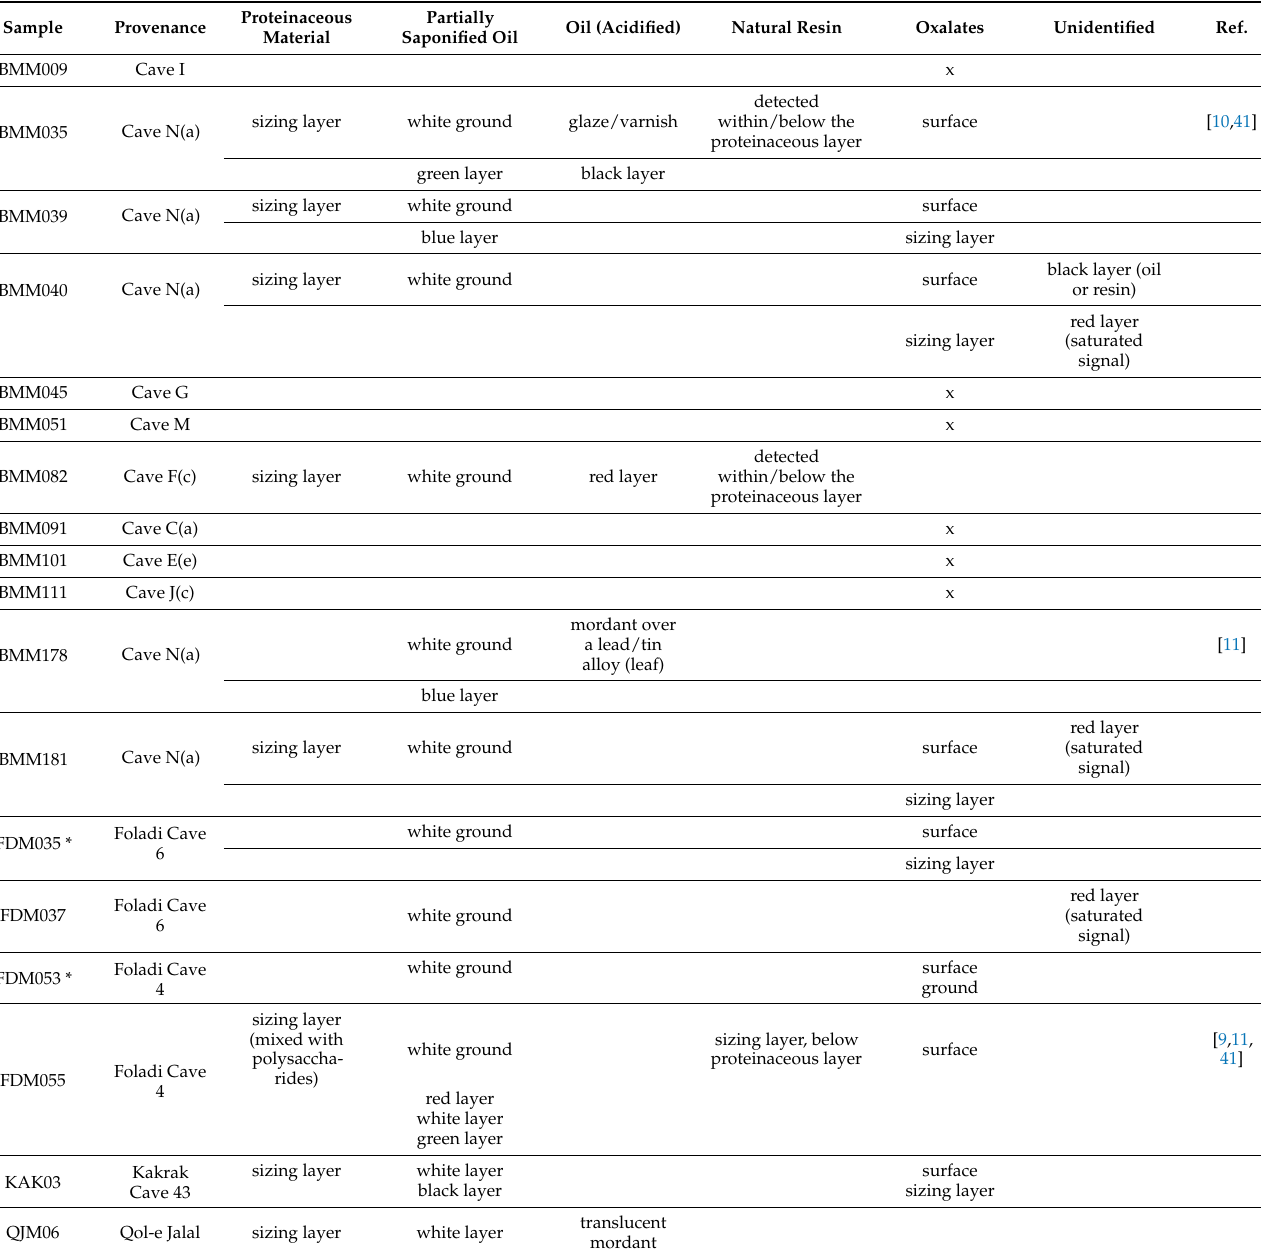
Table 3. Summary of the identification of the main organic components in Bamiyan’s paintings, using SR µ FTIR mapping. The location of the components is given when the sample structure was sufficiently well preserved. * Indicates samples that have been analyzed only as thin resin-embedded sections. x indicates that the component has been detected but not assigned to a specific